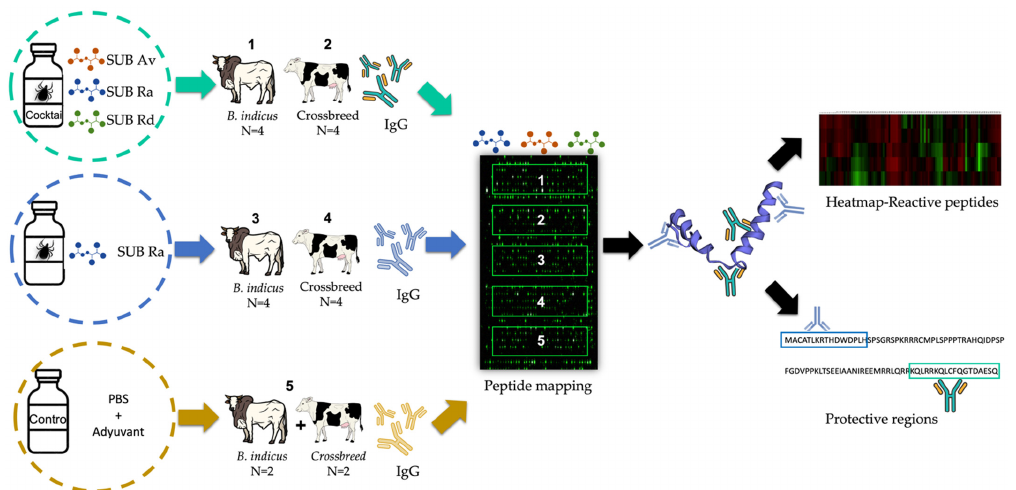
Figure 1. Experimental design of the study. Pooled serum samples used in the peptide mapping were from cattle breeds ( Bos indicus and B. indicus × B. taurus crossbred) common in Uganda, immunized with SUB from R. appendiculatus (SUBra), R. decoloratus (SUBrd) and A. variegatum (SUBav), and combined in a cocktail, SUBra alone and a control group immunized with PBS. In the control group, serum samples from only two animals from each cattle breed were used. A peptide microarray was performed for the identification of SUBra, SUBrd, and SUBav reactive epitopes and protective amino acid regions recognized by IgG antibodies from the immunized groups.